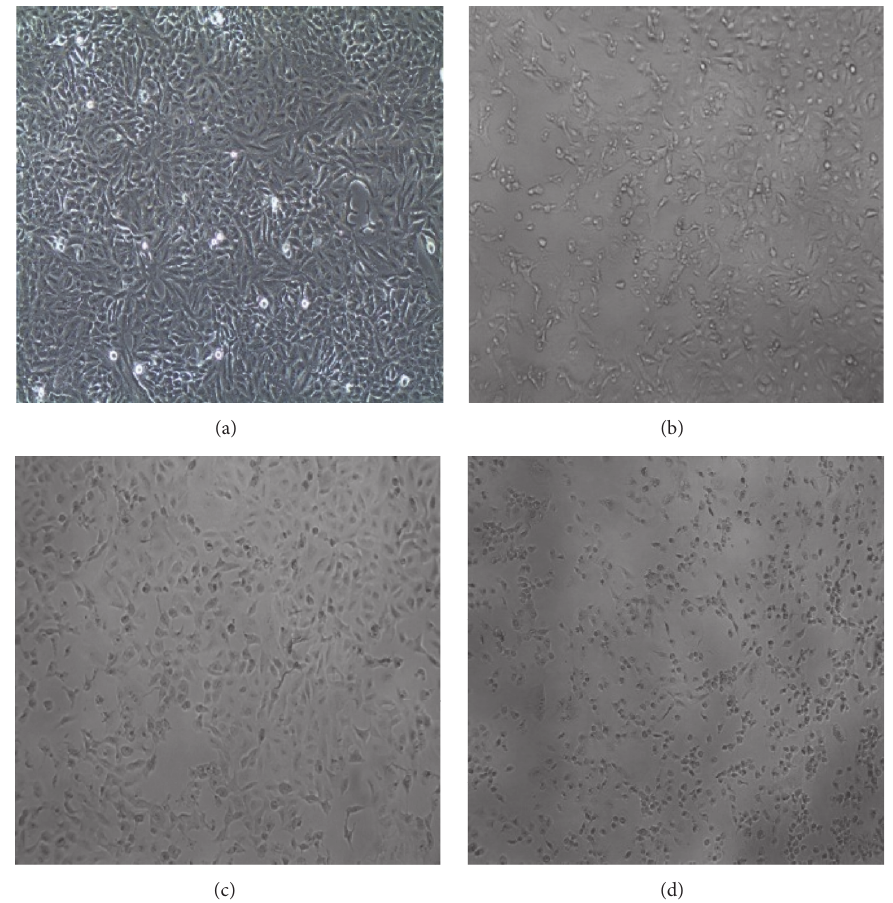
Figure 9: Cell morphology of A549 (a) before treatment; (b) after treatment, day 1; (c) after treatment, day 2; and (d) after treatment, day 3, treated with Clinacanthus nutans dried leaves extract. Cells were observed under light microscope at 40x